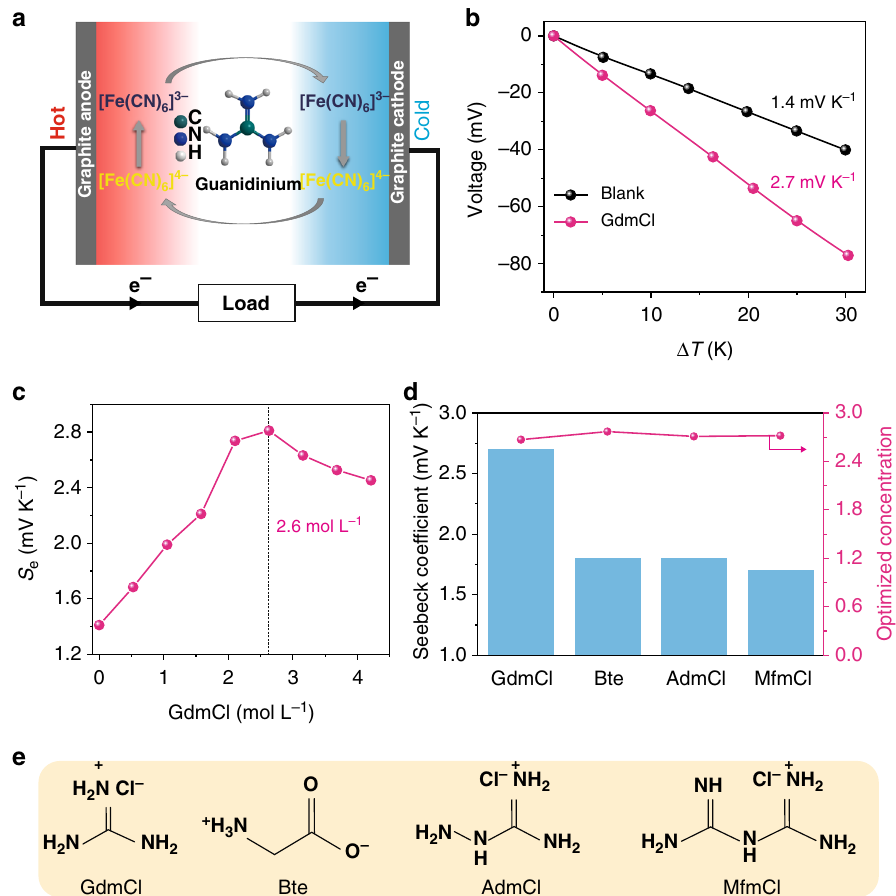
Fig. 1 TGC containing guanidinium in 0.4 M [Fe(CN) 6 ] 3 − /[Fe(CN) 6 ] 4 − . a The schematic operation mechanism for the TGC. b Dependence of the open- circuit voltage for the TGC systems on the temperature difference ( Δ T ) from 0 to 30 K; blank refers to the pristine [Fe(CN) 6 ] 3 − /[Fe(CN) 6 ] 4 − electrolytes without additives; GdmCl indicates the addition of guanidine chloride at the optimized concentration. c Dependence of the Seebeck coef fi cient on the concentration of GdmCl in the [Fe(CN) 6 ] 3 − /[Fe(CN) 6 ] 4 − electrolyte. d The Seebeck coef fi cients for TGCs containing different chaotropic species, including GdmCl, betaine (Bet), aminoguanidine chloride (AdmCl), and metformin chloride (MfmCl), and their corresponding optimized concentrations.